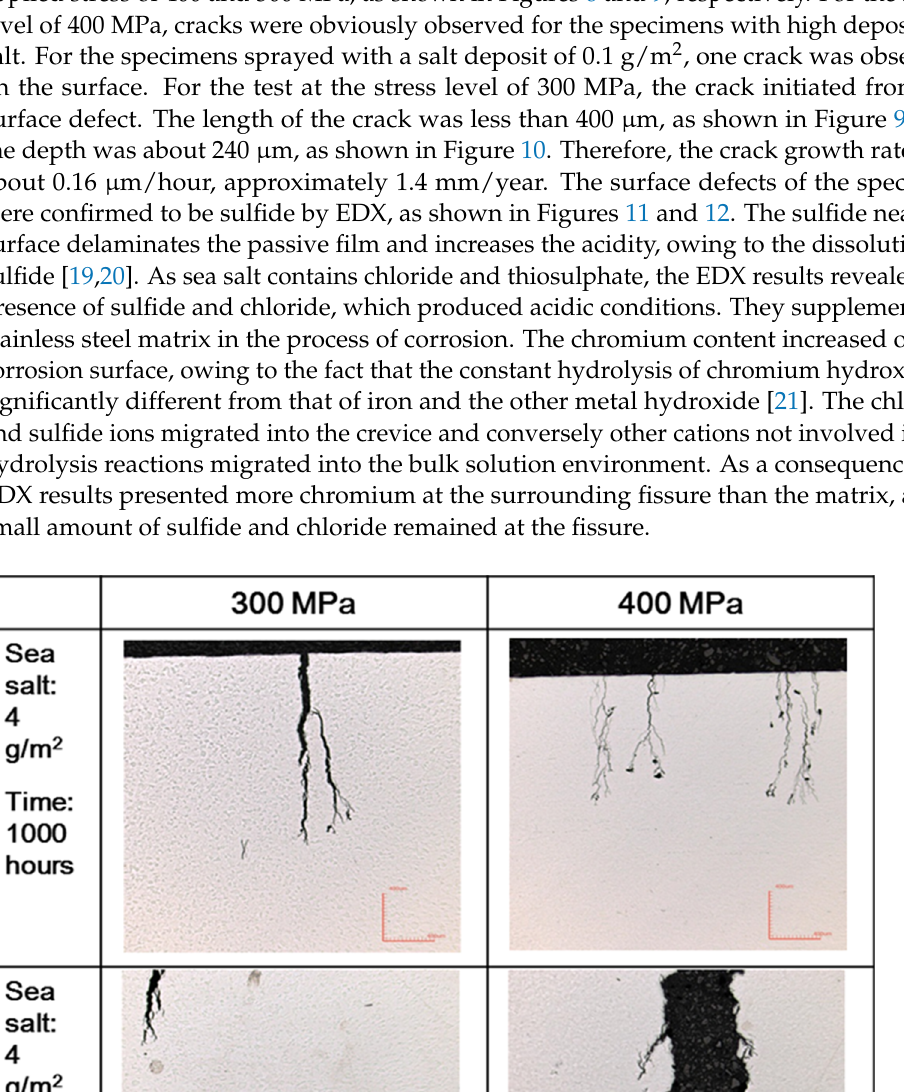
Figure 7. The crevice corrosion specimens with 0.1 g/m 2 of sea salt deposited on the surface were subjected to tensile stresses of 200 MPa, 300 MPa, and 400 MPa at a temperature of 45 °C for 1500 h for each testing condition.